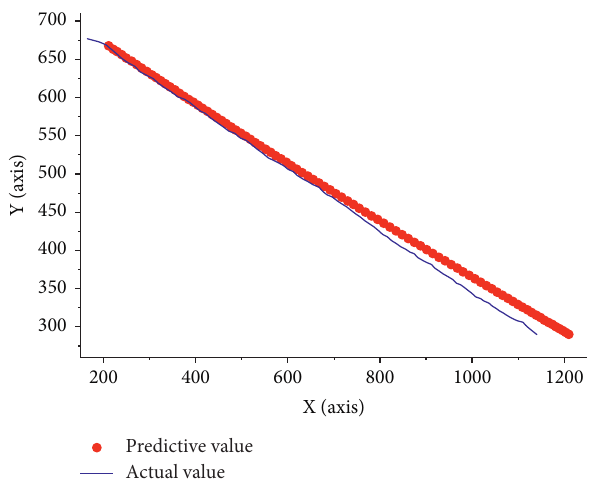
Figure 12: Prediction result of the straight trajectory.